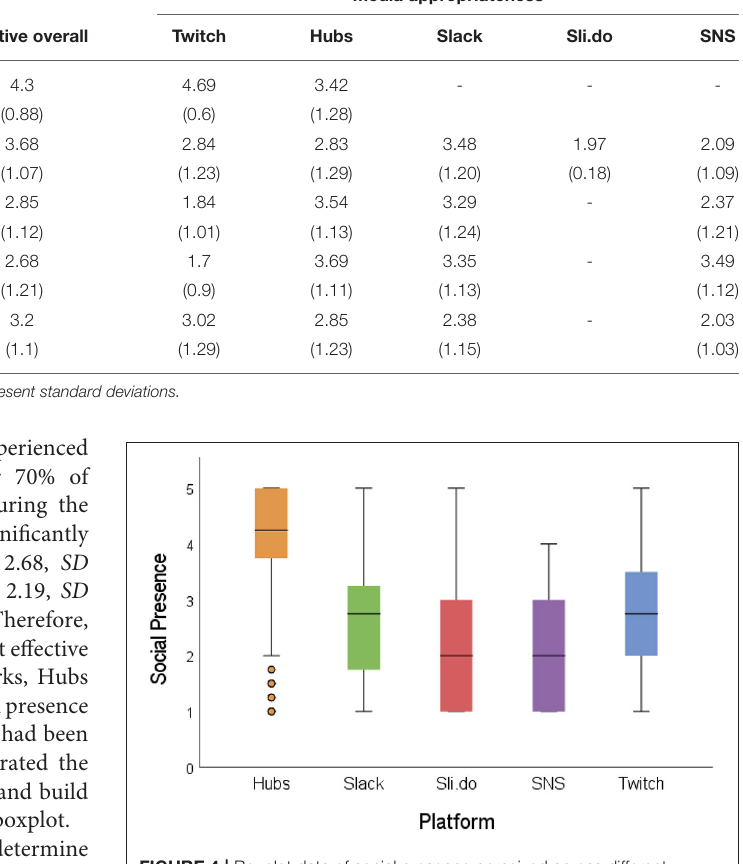
FIGURE 4 | Boxplot data of social presence perceived across different media